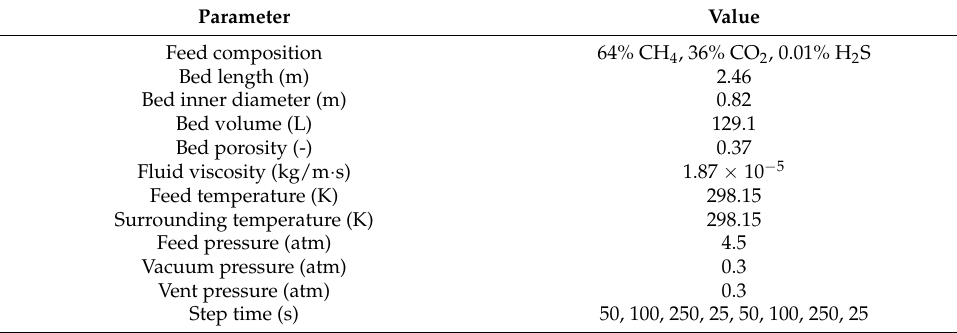
Table 19. Adsorption bed parameters and operating conditions for the full scale process.